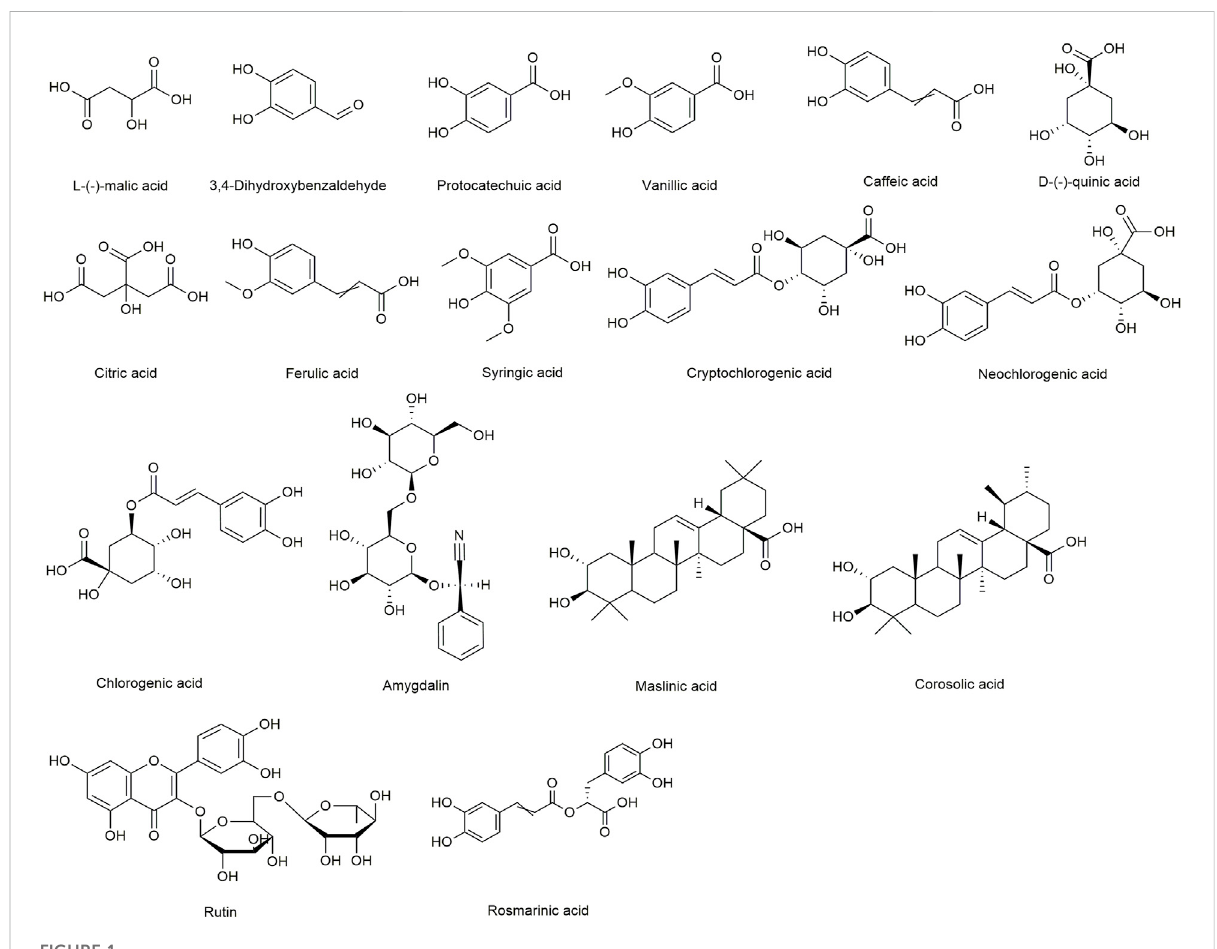
FIGURE 1 The chemical structures of the 16 analytes and